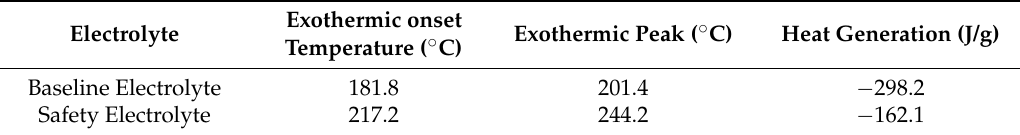
Table 1. Thermodynamics of baseline and safety